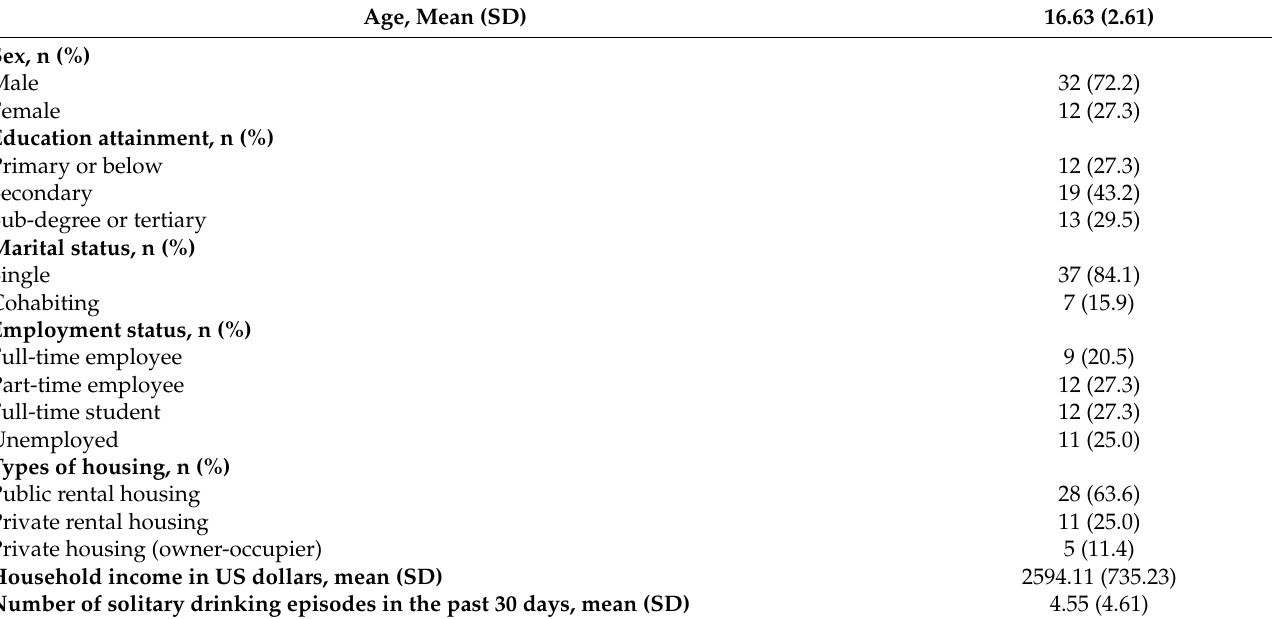
Table 1. Demographic and drinking characteristics of the respondents (n =